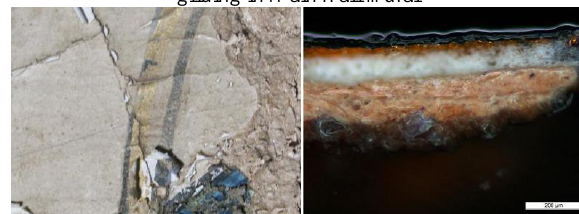
Figure 11 the microscopic cross-sectional structure of the gilding in Guan Yin Hall mural